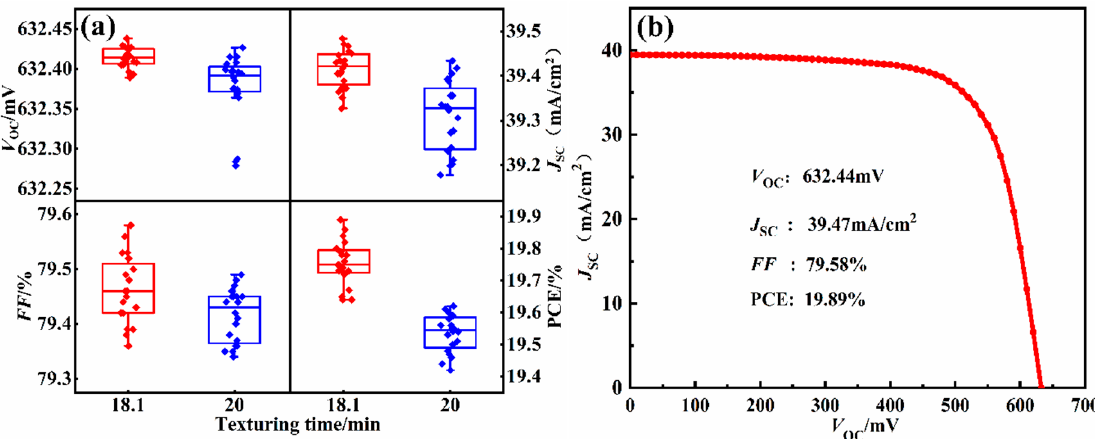
Figure 12. ( a ) Electrical properties of the silicon cells before and after process optimization. ( b ) The J-V curve of the best-efficiency solar cell after process optimization. (the J SC , V OC , and FF of the silicon cells are all improved to different degrees after the process optimization. The mean of PCE is 19.76%, which is 0.22% higher than that of the silicon cell textured for 20 min. The J-V curve of the best-efficiency solar cell after process optimization was measured, the V OC is 632.44mV, the J SC is 39.47mA/cm 2 , and the PCE has the best efficiency of 19.89%.)